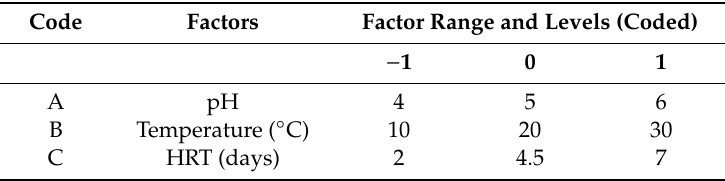
Table 1. Box–Behnken design for three factors in experimental design.